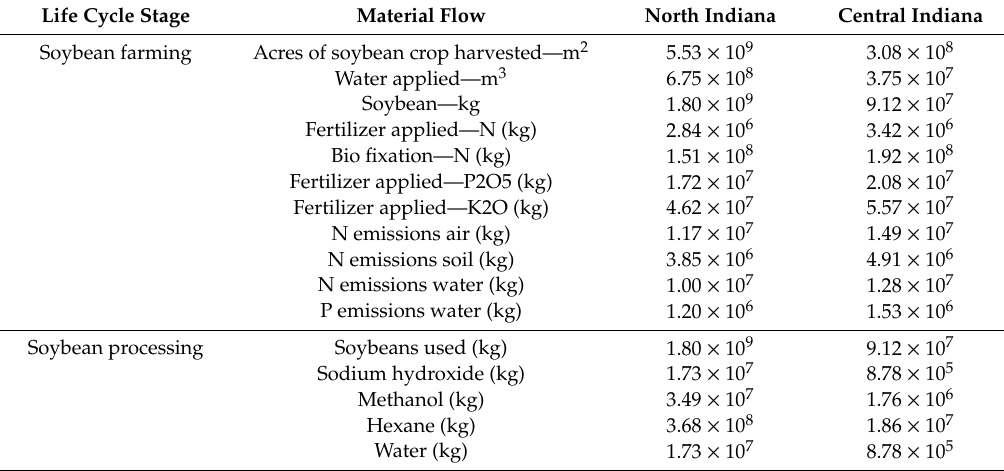
Table 2. Aggregated inventory data for north and central biodiesel production life cycle stages